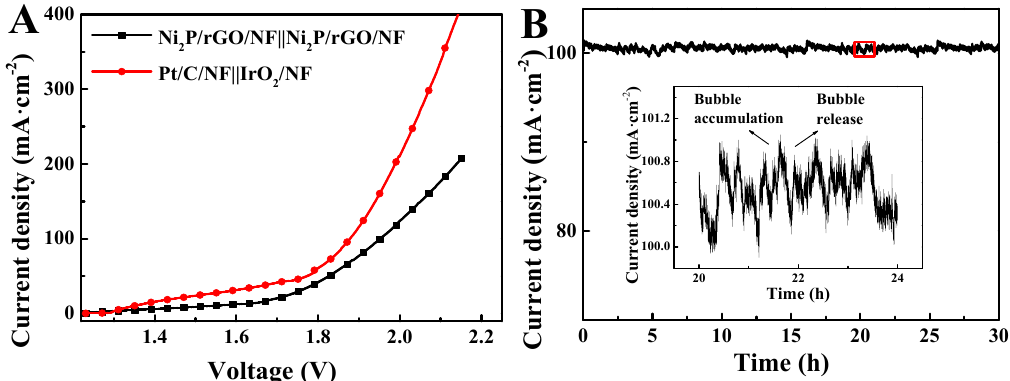
/ rGO / NF || Ni / rGO / NF. 2 P